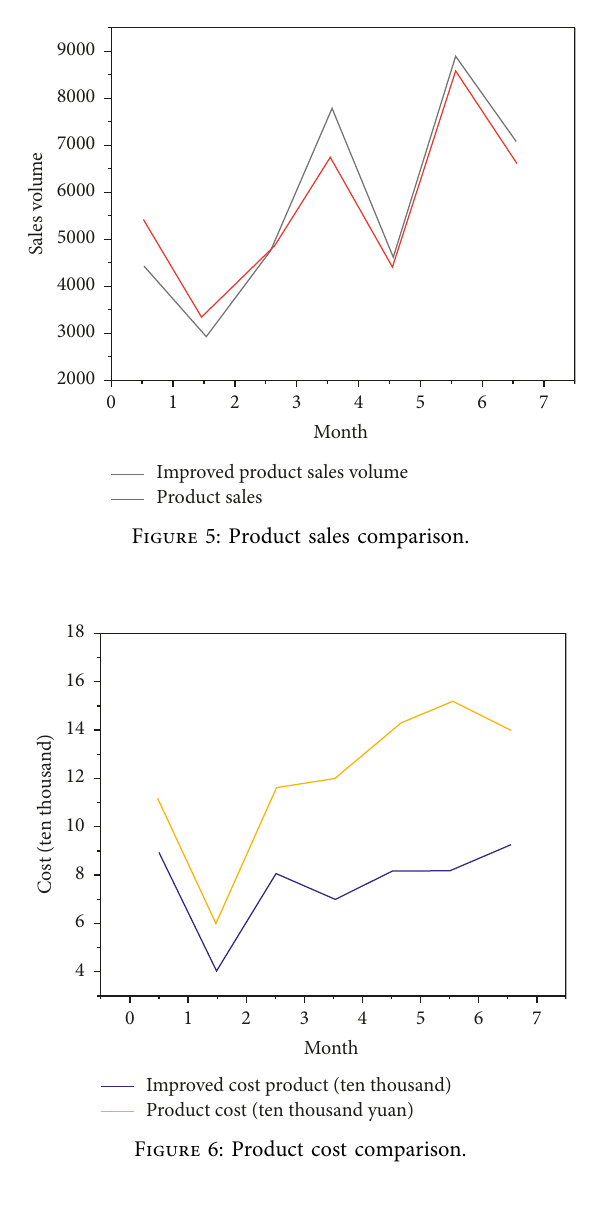
Figure 6: Product cost comparison.